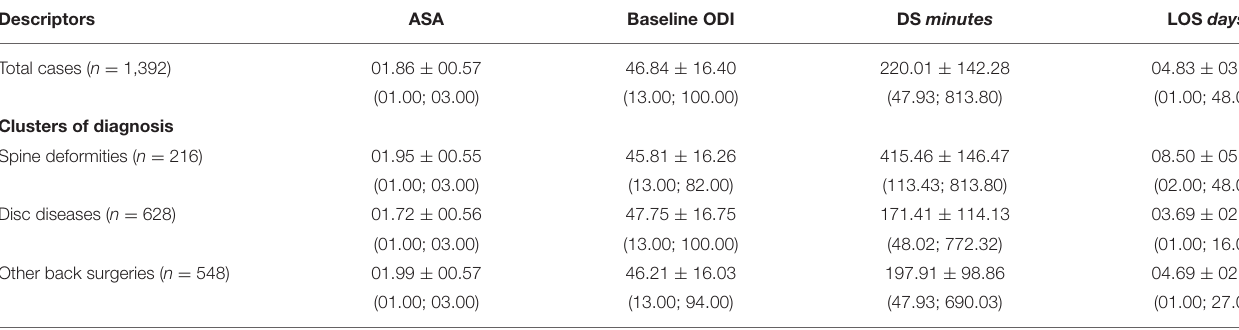
TABLE 3 | Baseline surgical descriptors of the study group.